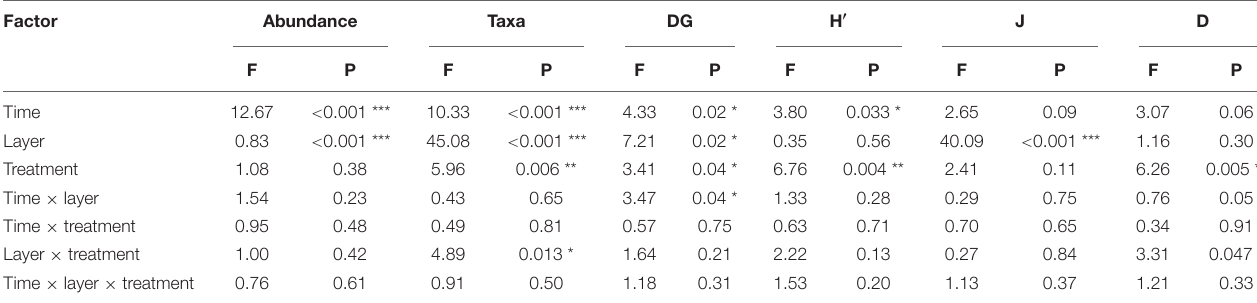
TABLE 1 | Main and interaction effects of the N addition period (Time), soil layer depths (Layer) and N addition treatments (Treatment) on community abundance, taxa, and diversity indices (MANOVA results are